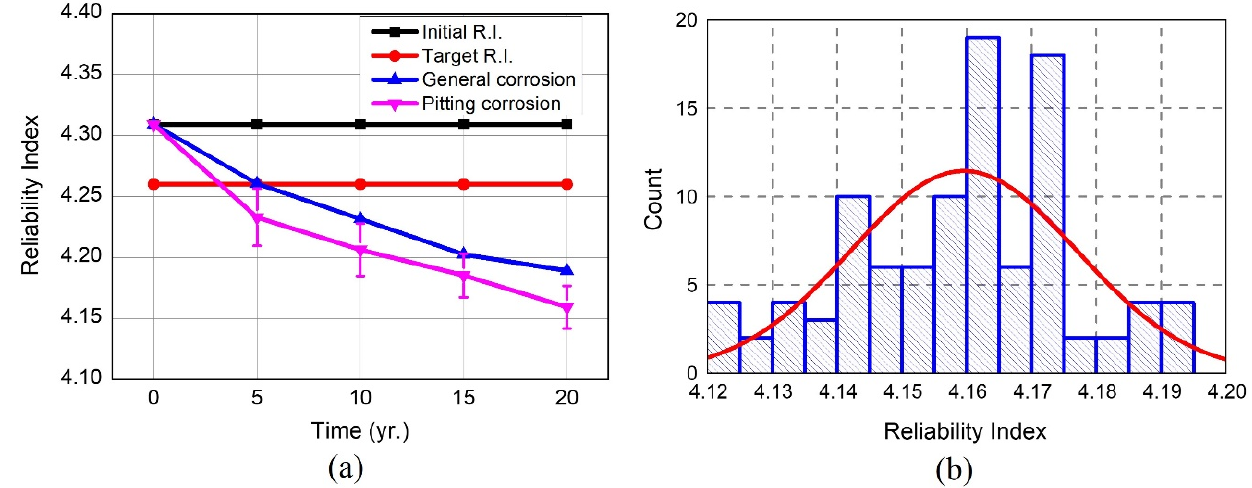
Figure 8. Results of structural reliability analysis with pitting corrosion; ( a ) reliability index; ( b ) distribution of reliability index.